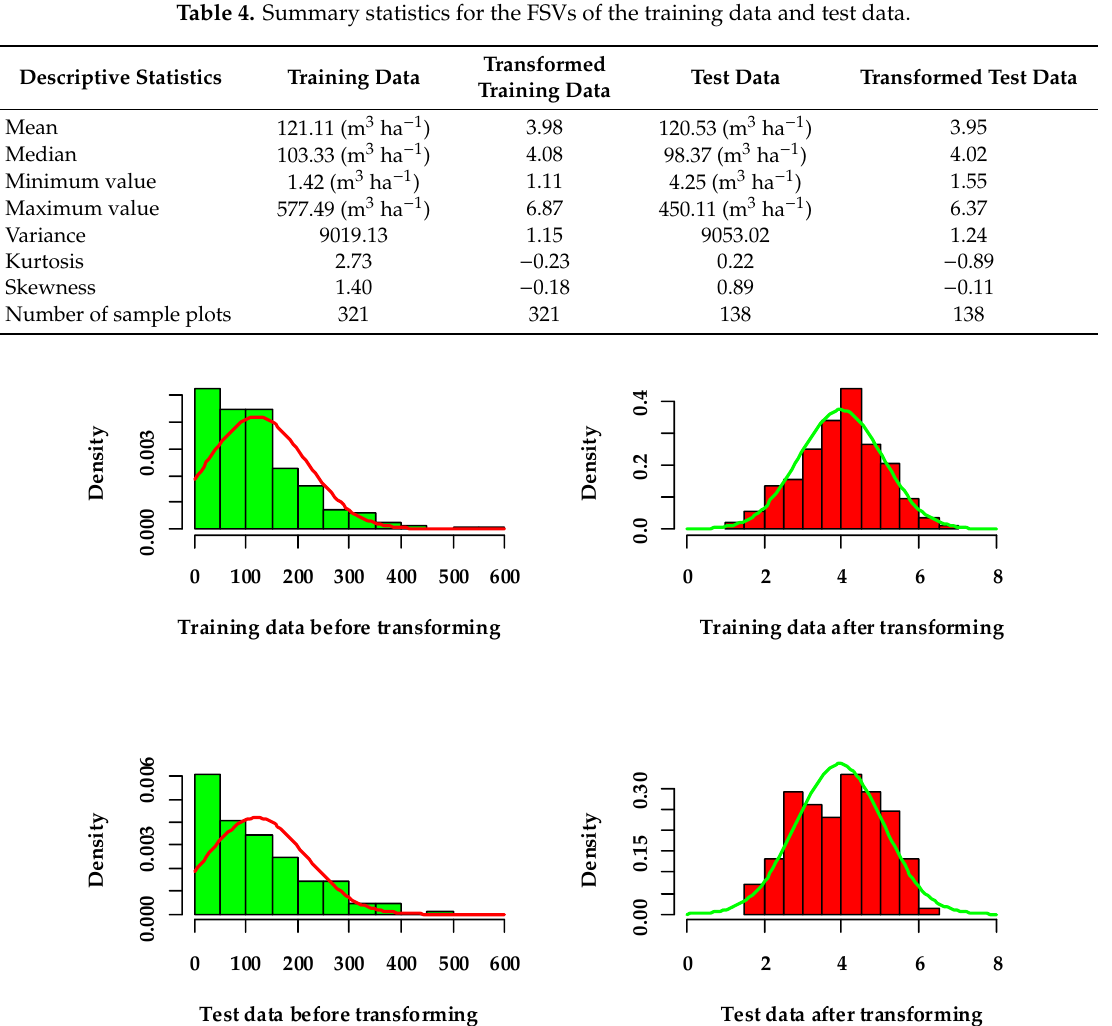
Figure 3. Training and test data distributions before and after transforming. The green and red histograms represent the distribution before and after data transformation, respectively; the red and green curves represent the distribution before and after data transformation, respectively.